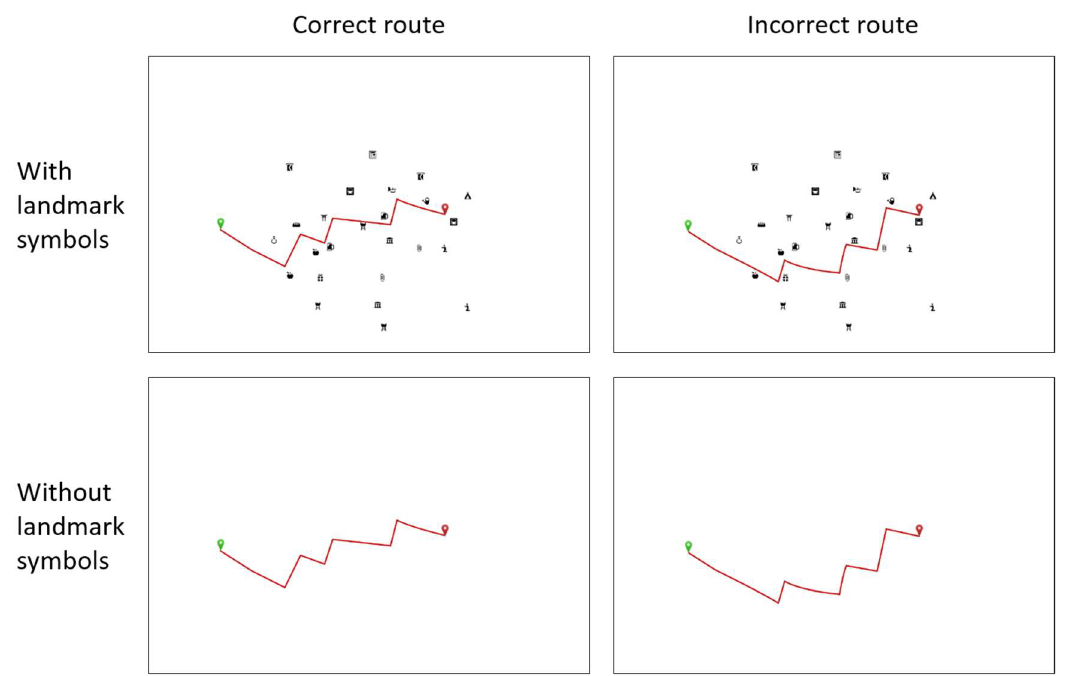
Figure 2. Recognition stimulus variants. After each study map, four recognition stimuli were shown to the participants. At least one of these stimuli contained the same route as the study map. The rest contained slightly changed route shapes. Whether landmark pictograms were displayed in a recognition stimulus was determined at random.